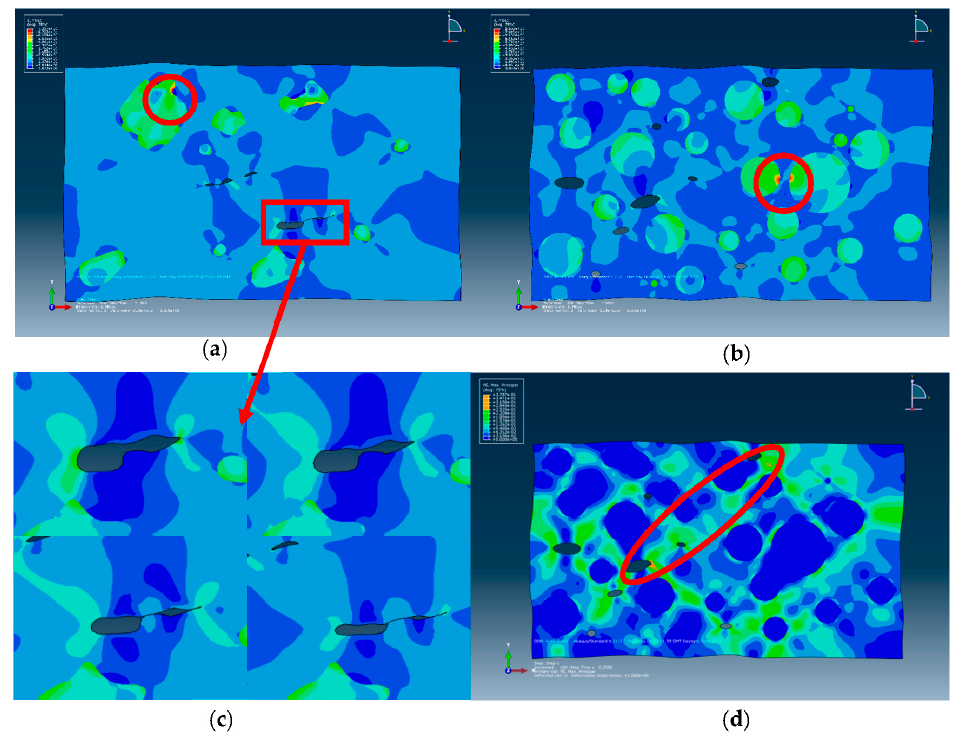
Figure 7. Deformation and contour of von Mises stress and plastic strain: ( a ) von Mises stress distribution of 4-R model; ( b ) von Mises stress distribution of 4-S model; ( c ) deformation of microvoid over time; ( d ) plastic strain distribution of 4-S model. Red circles indicate maximum shear stress points, and the red rectangle indicates the positions of microvoids in ( c ); red elliptical circle indicates the 45° shear bands in ( d ).